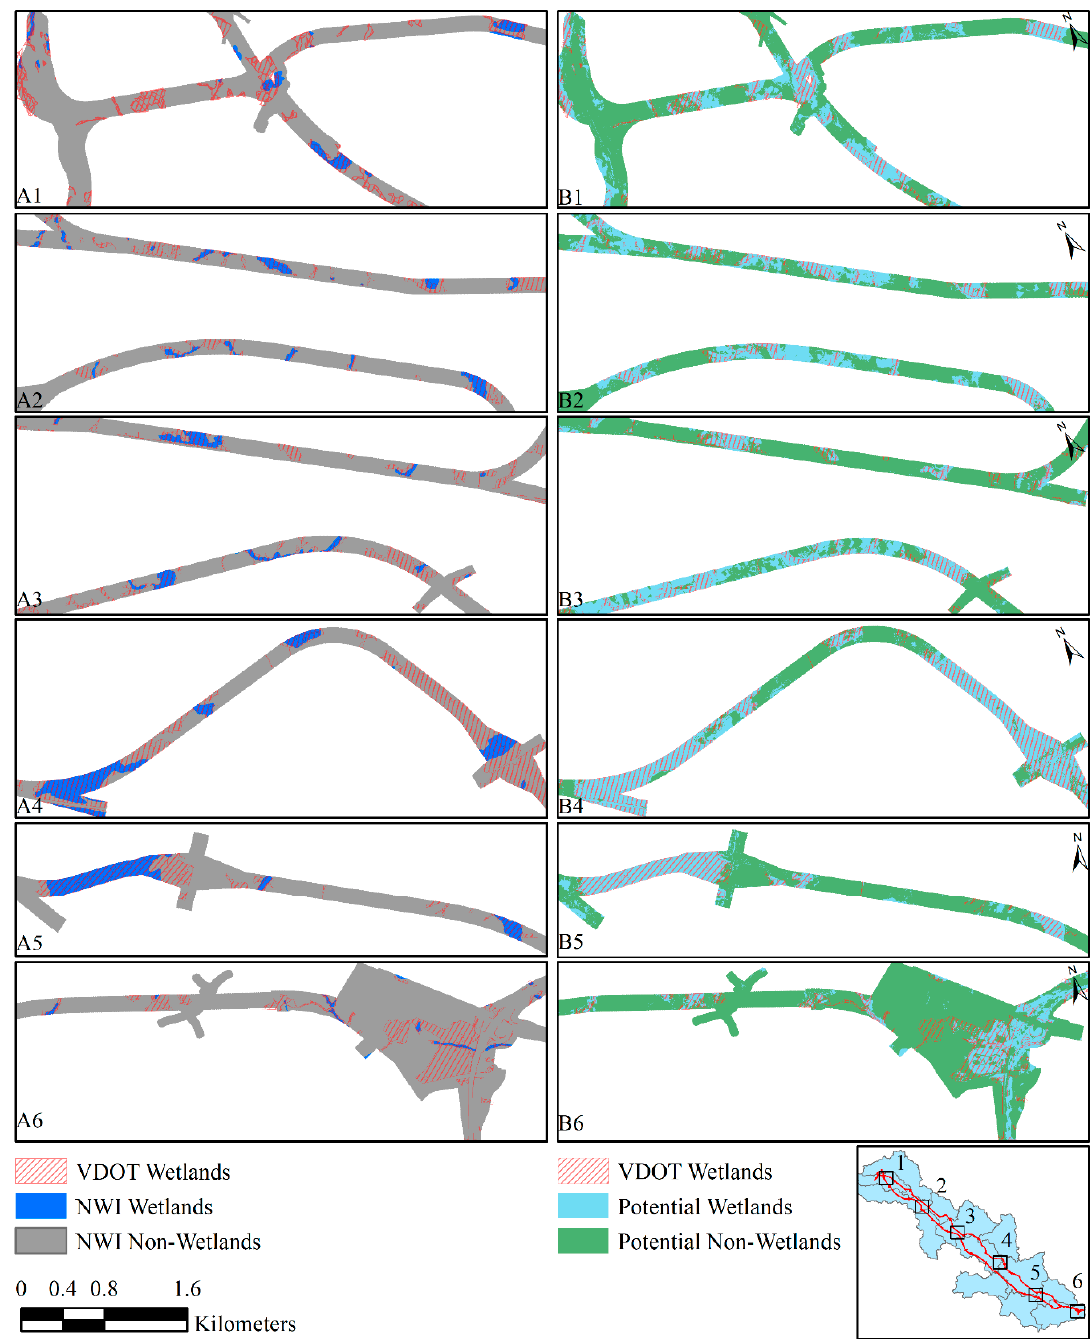
Figure 5. Examples of the wetland screening tool output for selected areas of the VDOT delineation area ( B1 – B6 ) compared to NWI mapping for the same scenes ( A1 – A6 ). VDOT wetlands, used to train and assess tool output, show the true distribution of wetlands. The location of scenes within the study area is shown in the lower right, labeled 1–6.